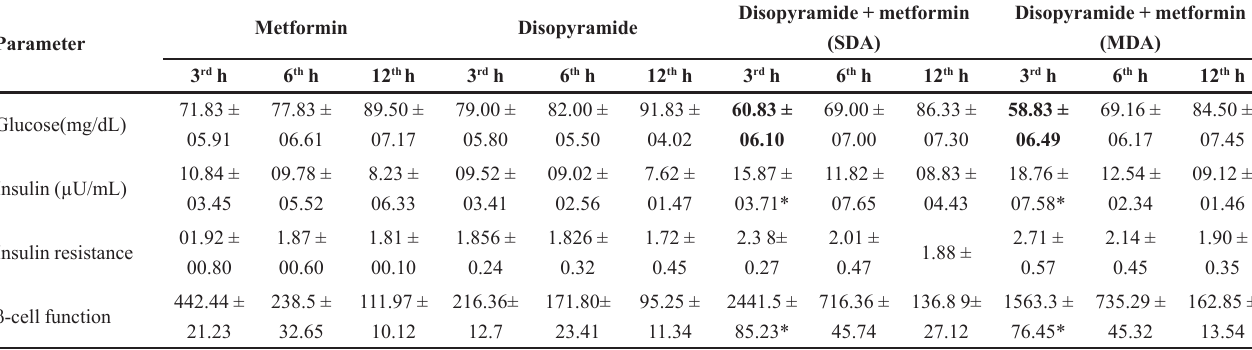
TABLE V - Effect of disopyramide on the activity of metformin in normal rabbits (N=6)